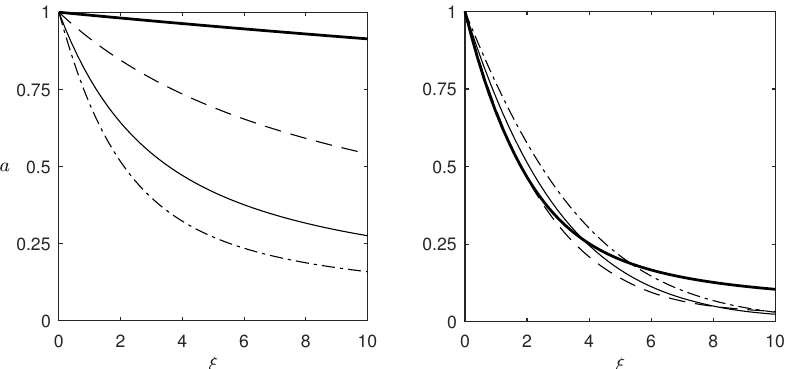
Figure 3. Effects of dimensionless mud thickness, d , on the damping of a solitary wave: dimensionless wave height, a , as a function of dimensionless time, ξ . Left: d = 0.5 (bold line), 1 (dashed line), 1.5 (solid line), 2 (dashed-dotted line). Right: d = 2.5 (bold line), 5 (dash line), 7.5 (solid line), 10 (dashed-dotted line). In all cases, Wi = 1.